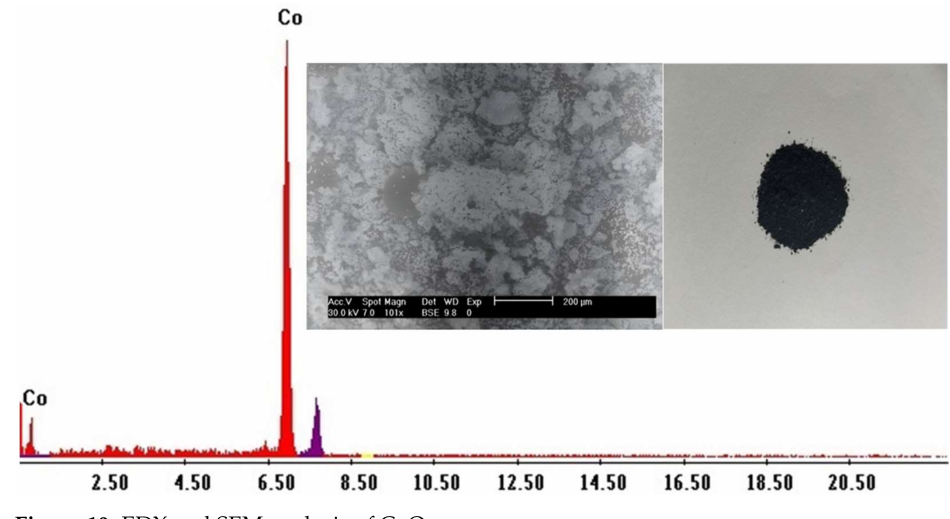
Figure 10. EDX and SEM analysis of CoO.